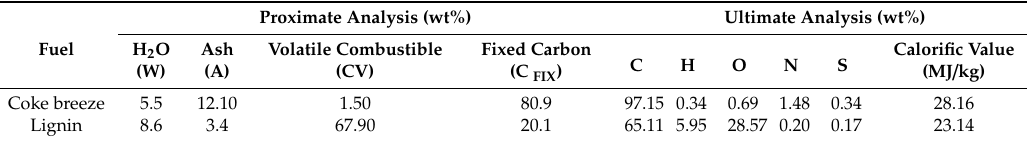
Table 2. Chemical analysis and energy content of